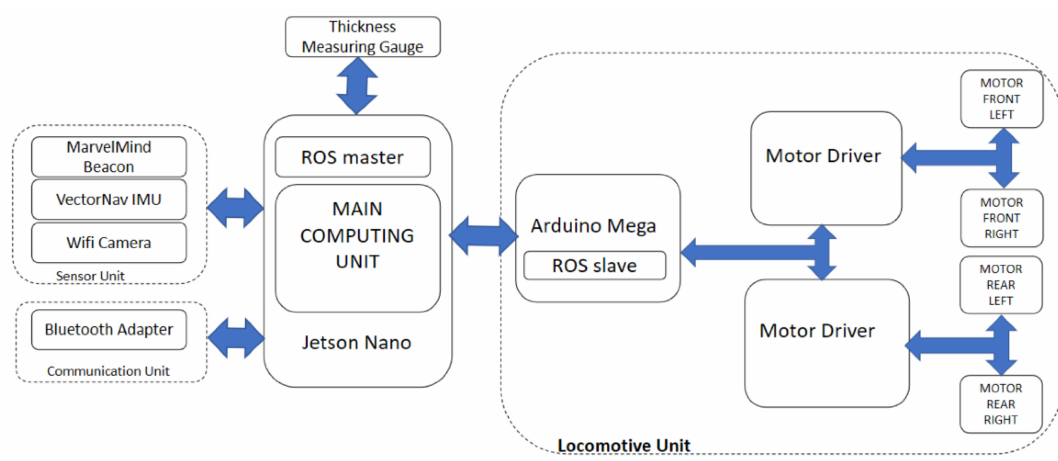
Figure 30. The hardware architecture of Sparrow, an autonomous robot